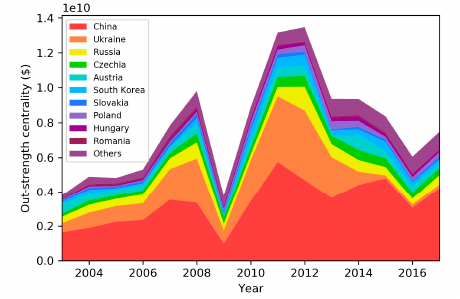
Figure 4. Intraregional export volume of the top 10 BRI exporters.